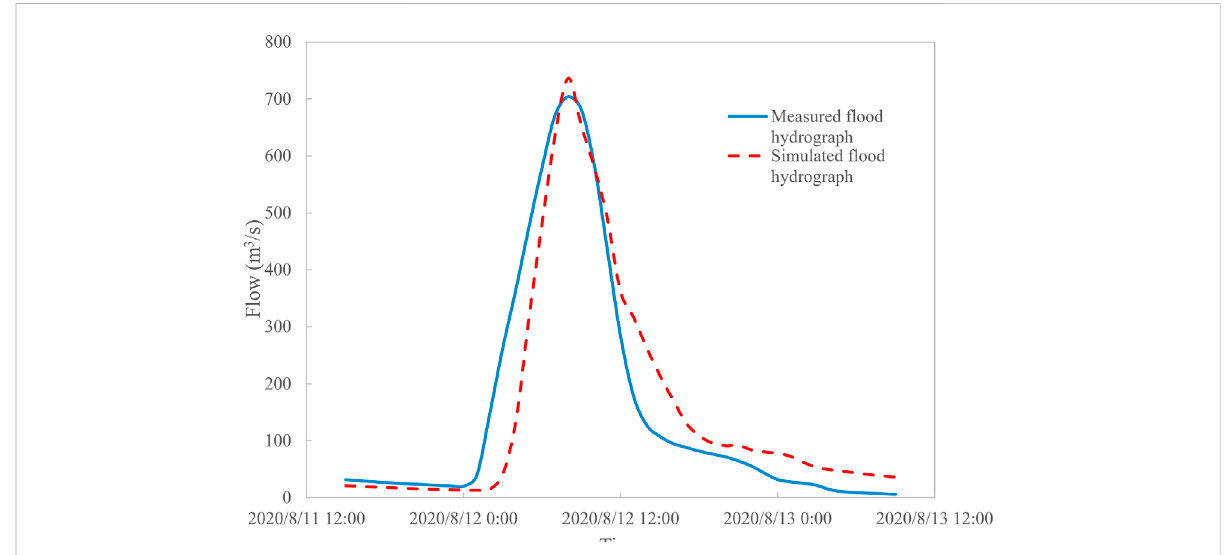
FIGURE 2 Flood hydrograph of Yujiantan gauging station on 12 August 2020.